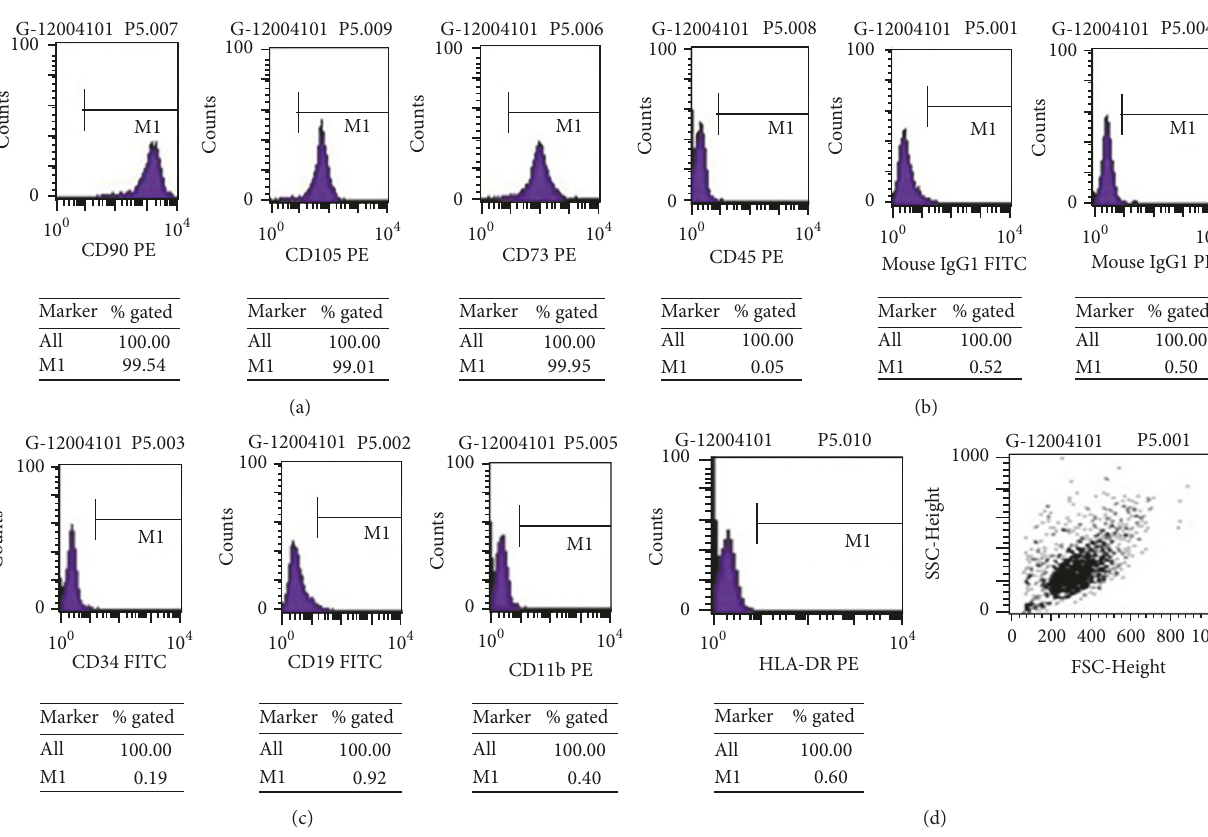
Figure 2: Fluorescence-labeled cell sorting analysis from hUC-MSCs of (a) CD90, CD105, and CD73; (b) CD34, CD19, and CD11b; (c) CD45; and HLA-DR and